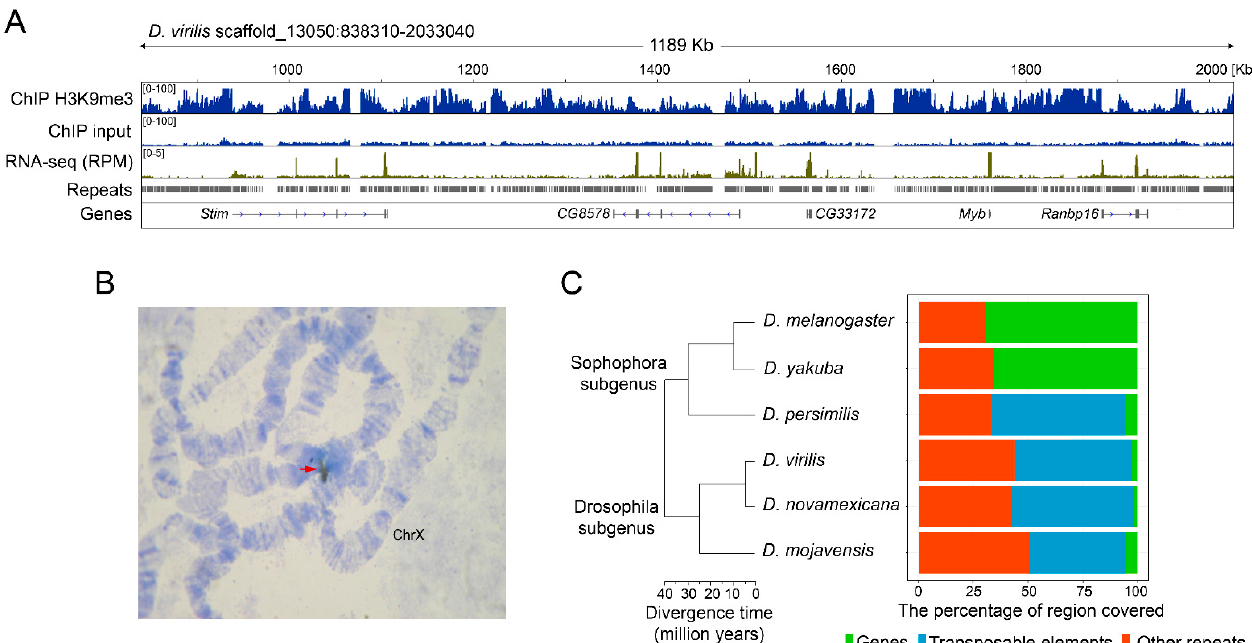
Figure 1. Landscape of pericentric heterochromatin region in chromosome X of D. virilis . ( A ) Genomic map of the region in scaffold_13050 of reference genome of D. virilis defined by protein-coding genes Stim , CG8578 , CG33172 , Myb , and Ranbp16 located in this scaffold with mapped ChIP-seq reads of heterochromatic markers H3K9me3. Input for ChIP-seq data is also shown. RNA-seq reads were normalized to the sequence depth (RPM, reads per million). Repeats and protein-coding genes are shown as different tracks. ( B ) DNA in situ hybridization of Myb gene probe to polytene chromosomes of D. virilis . The black arrow indicates the hybridization signal at the base of chromosome X of D. virilis . ( C ) Genomic content between the same five protein-coding genes Stim , CG8578 , CG33172 , Myb , and Ranbp16 in different Drosophila species. Due to different distances between genes, the number of annotated genomic features was normalized to the length of the analyzed region for each species. Transposable elements include LTR and non-LTR (LINE) retrotransposons, DNA, miniature inverted repeat transposable elements (MITEs), and Rolling circle elements. Other repeats represent non-transposable element (TE) related sequences including satellite DNA and simple repeats. Unrooted phylogenetic tree indicates the relationships among species with the estimated time of divergence according to Clark et al. and O’Grady et al. for the virilis group